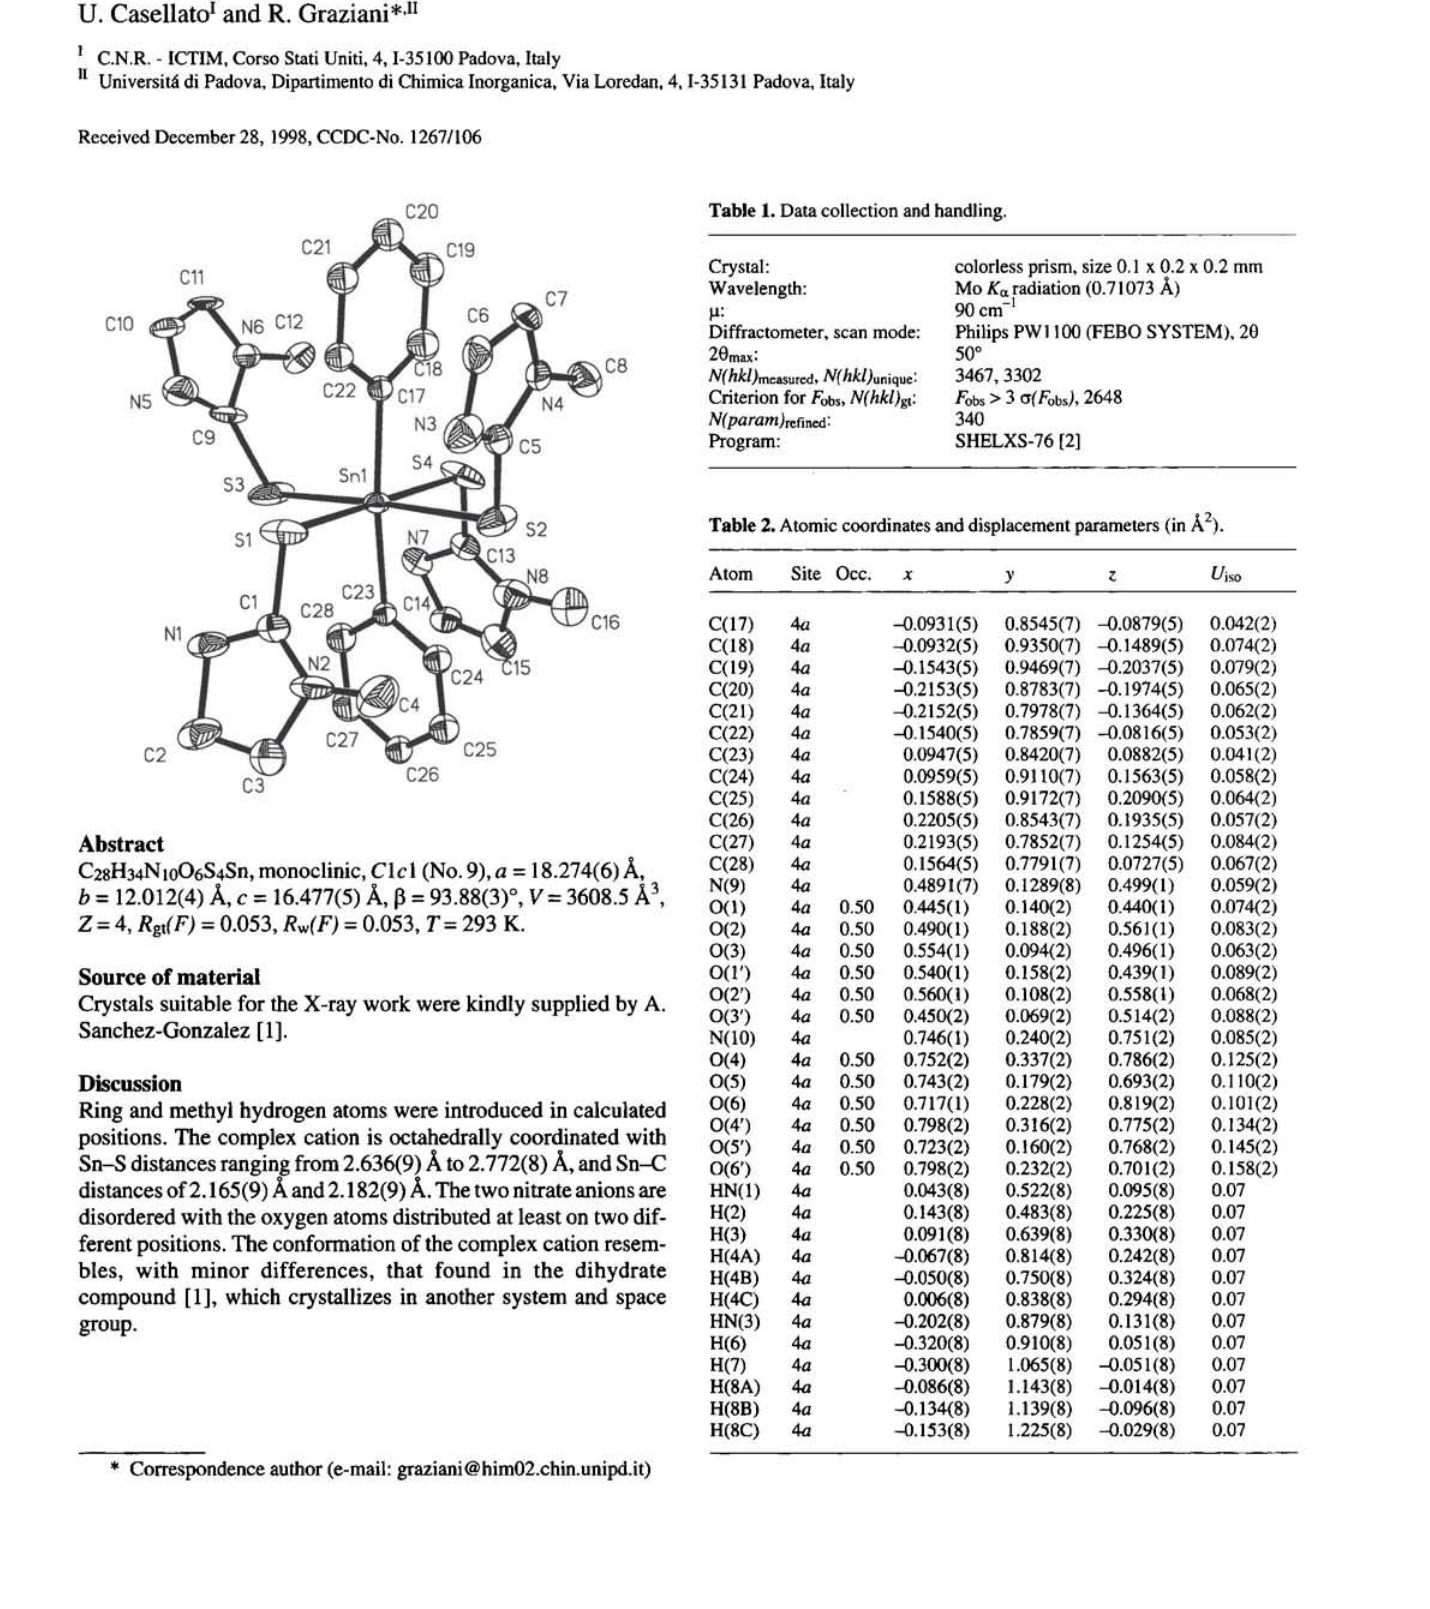
Table 2. Atomic coordinates and displacement parameters (in Â 2